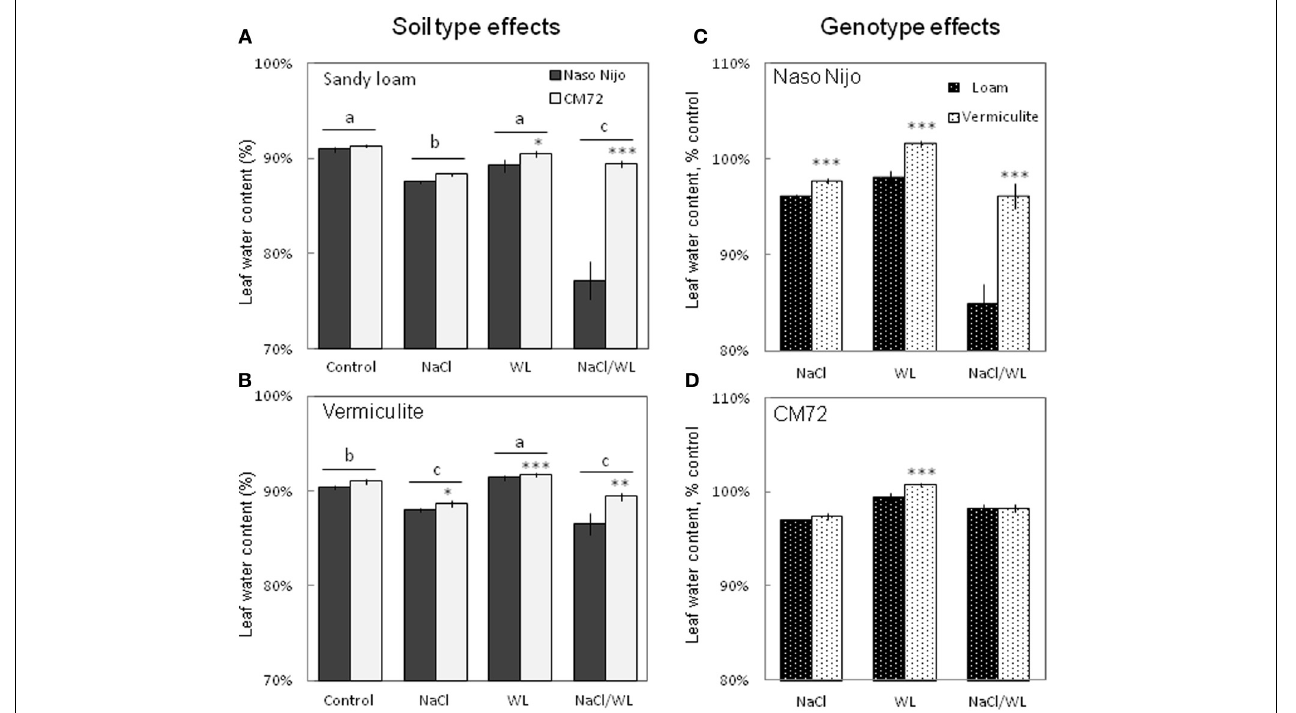
the Materials and Methods section. Mean ± SD ( n = 5). Different lower case letters indicate the significant difference between treatments (averaged for both genotypes) at P < 0 . 01. Asterisks indicate the significant difference between cultivars within the treatment at ∗ P < 0 . 01, ∗∗ P < 0 . 001, and ∗∗∗ P < 0 .